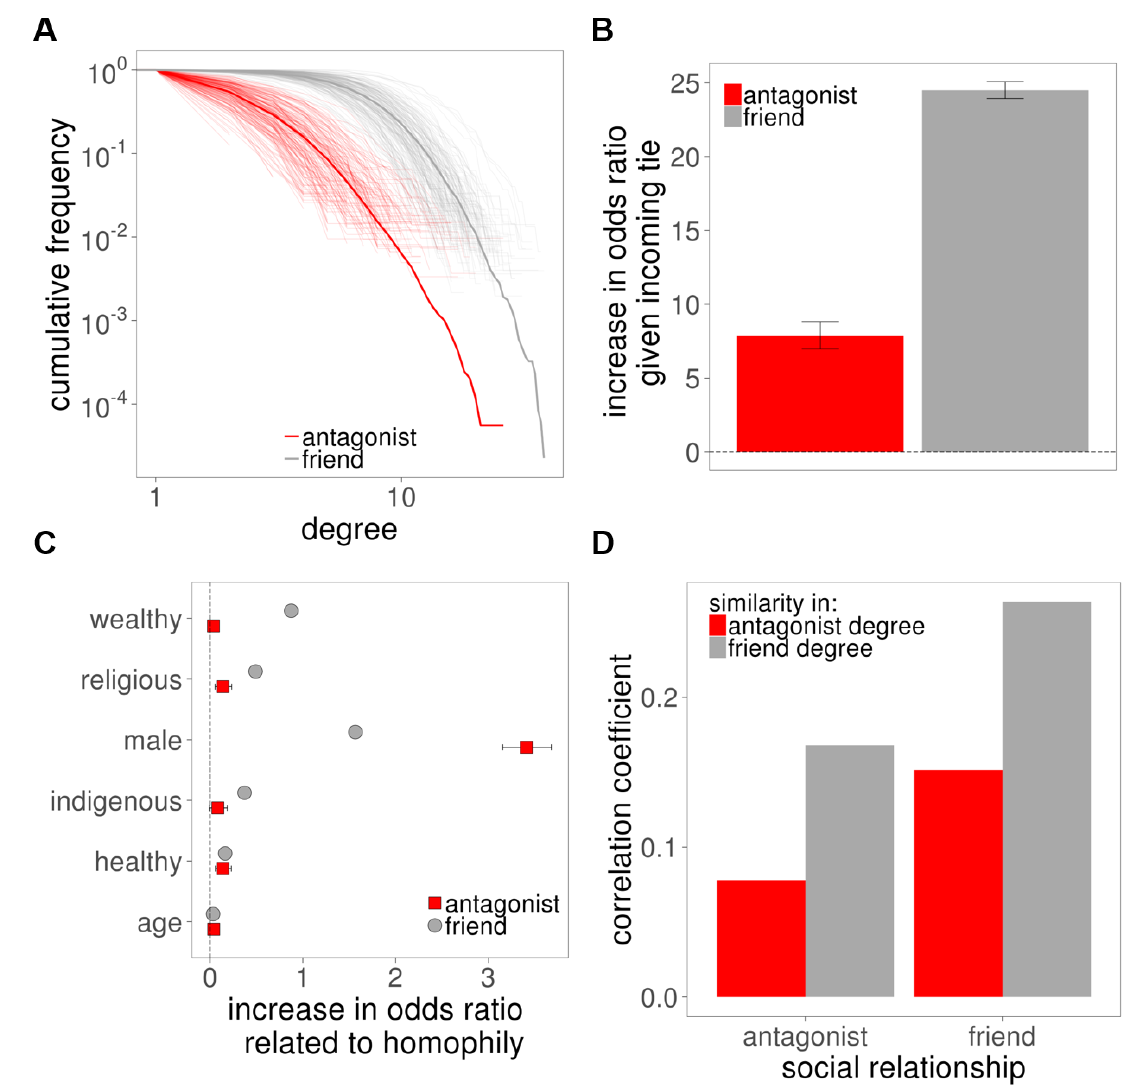
Figure 3: Properties of positive and negative ties. (A) Degree distribution of friend and antagonistic ties across 176 villages with 105,175 positive and 16,448 negative ties. Transparent lines represent observed cumulative degree distributions for friends (gray) and antagonists (red) for each symmetrized village network. Solid lines represent the average distribution. Axes are log scale. (B) Increase in the odds of the ego naming the alter as an antagonist (friend) given that the alter named the ego as an antagonist (friend) based on estimates from a dyadic model with fixed effects (see the Methods section). (C) Increase in the odds of an outgoing tie ( x axis) based on dyadic models of social ties indicate how much a one-unit change in homophily (similarity) in each of the variables shown ( y axis) is associated with increased odds of a social tie. Gray circles indicate friends, and red squares indicate antagonists. Black lines around estimates indicate 99.5 percent confidence intervals (see the online supplement). Both friends and antagonists show homophily on the indicated traits. (D) Pearson correlations with respect to the network degree of connected individuals. Red bars correspond to similarity in antagonist degree, and gray bars correspond to similarity in friend degree for the given social relationship ( x axis) between pairs of nodes. Among pairs of friends, the number of friends and antagonists is correlated, as it is among pairs of